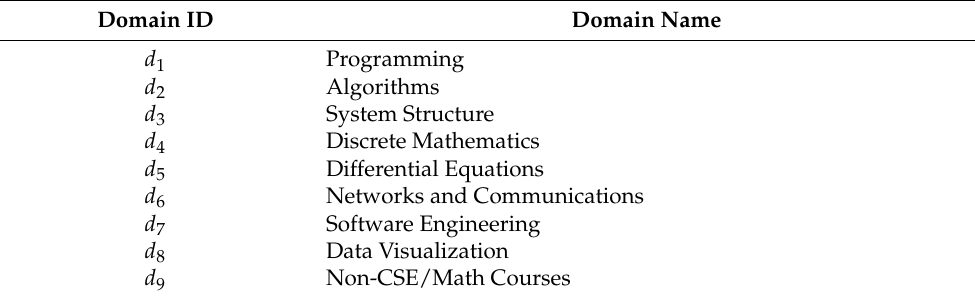
Table 1. List of domains identified by